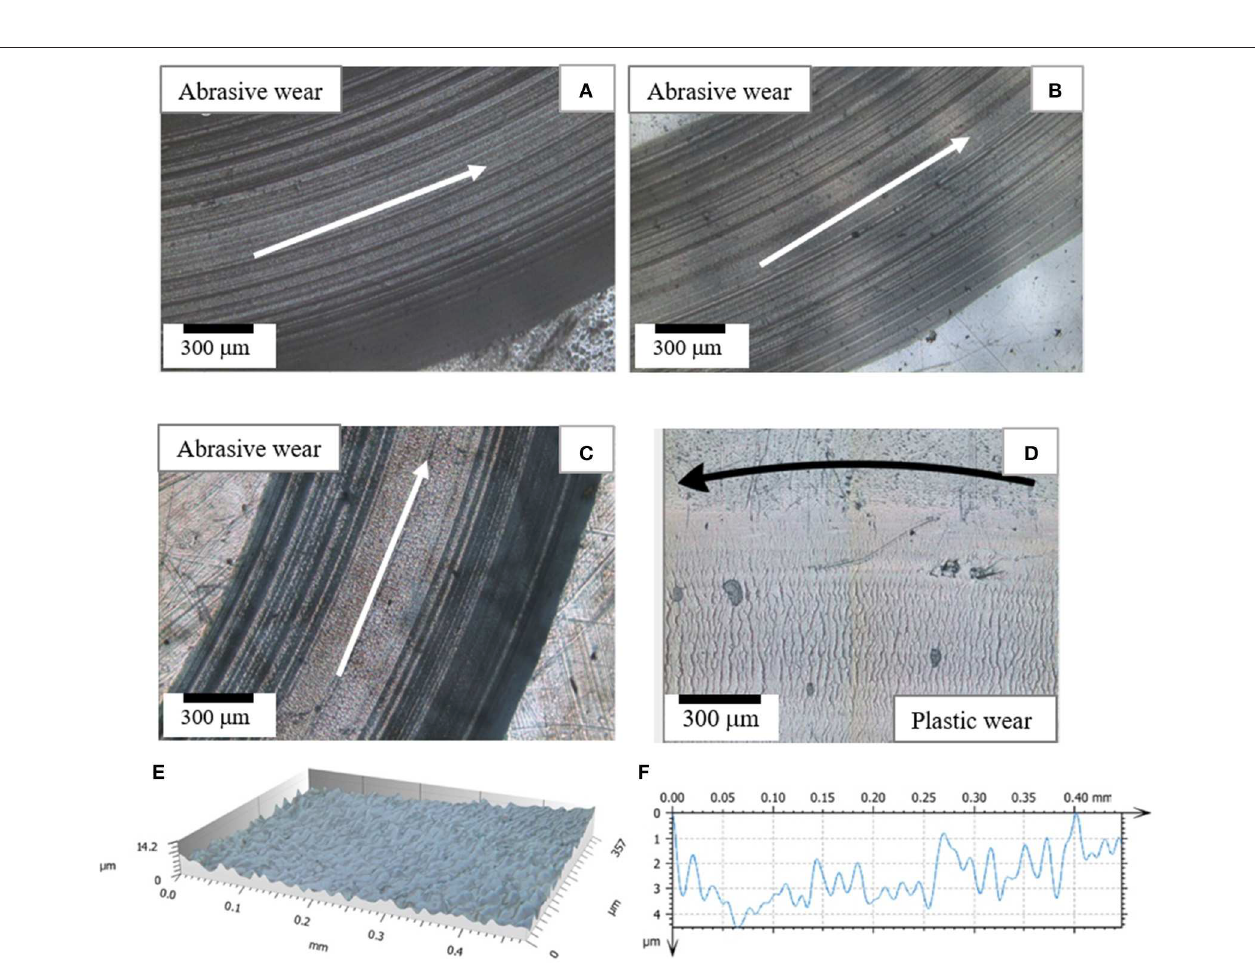
FIGURE 11 | Optical microscopy micrographs of the different tested specimen (A–D) with sliding direction arrow marked: unreinforced Nucrel (A) and Surlyn (B) ; reinforced Nucrel (C) , and reinforced Surlyn (D) . Optical profilometer data: (E) high magnification 3D micrograph of the central part of the worn track of Su/ePLA/Su specimen and (F) cross-section profile of the central part of the worn track of this sample.